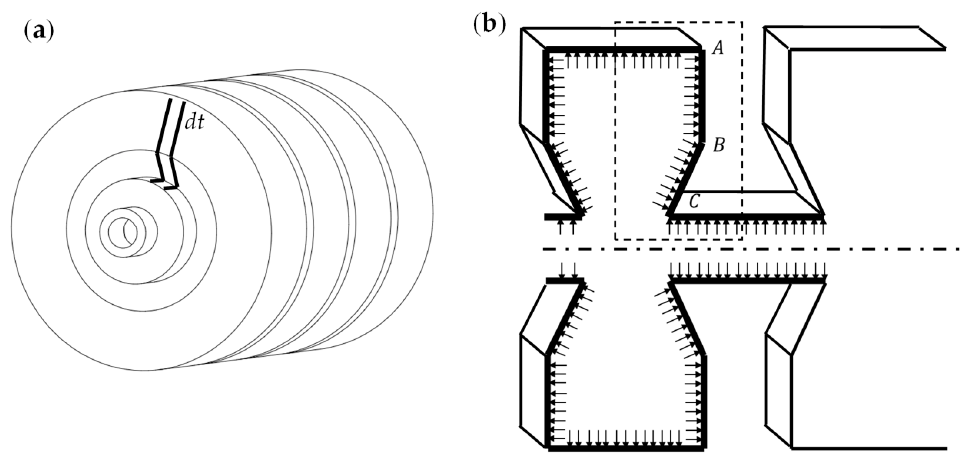
− − . Figure 8. Actuator slice analysis. ( a ) Slice position. ( b ) Key structure A − B − C